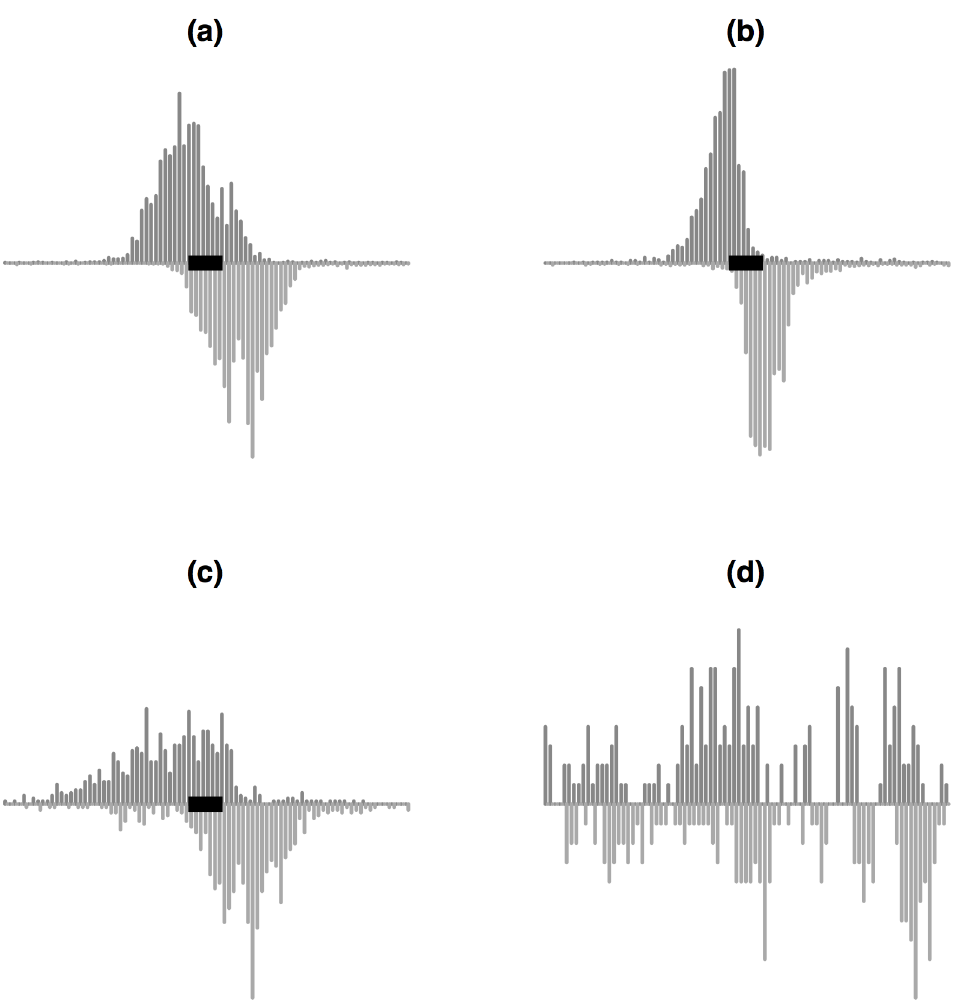
Figure 1. Illustration of peak shapes from three good binding sites (a, b, c) and one false positive (d). X-axis is genomic location centered at the summit of each peak. Y-axis represents ChIP read counts in 10 bp genomic windows. For each peak, data from the IP sample in a 800 bp window surrounding the MACS peak summit is shown. Bars above the middle represent counts from forward strand, and bars below represent the counts from reverse strand. The black rectangles illustrate the TF binding sites. (a) and (b) are two different binding sites from the same ChIP-seq dataset, and (c) is a binding site from a different dataset. They illustrate that peak shapes at true TFBSs are similar but can vary across binding sites and